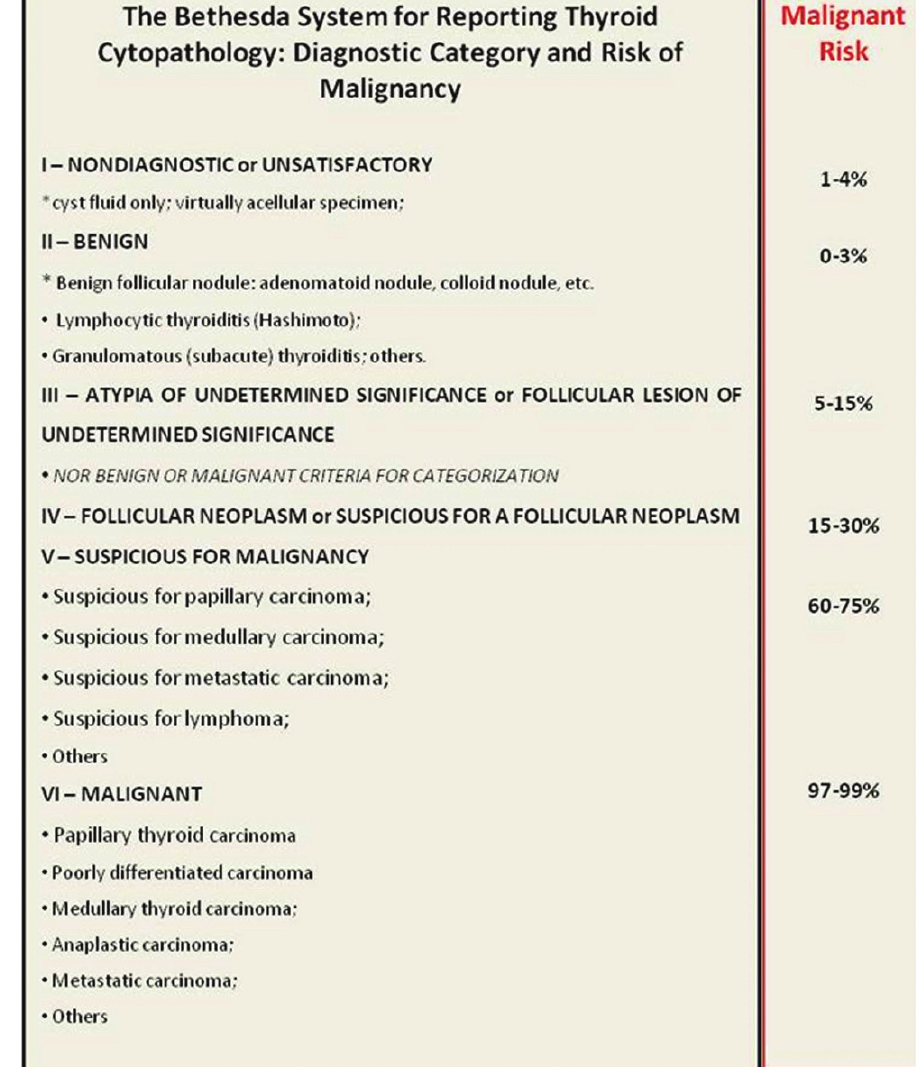
Figure 2 - The Bethesda cytological classification system and its correlation with the risk of thyroid nodule malignancy. Adapted from Theoharis et al.